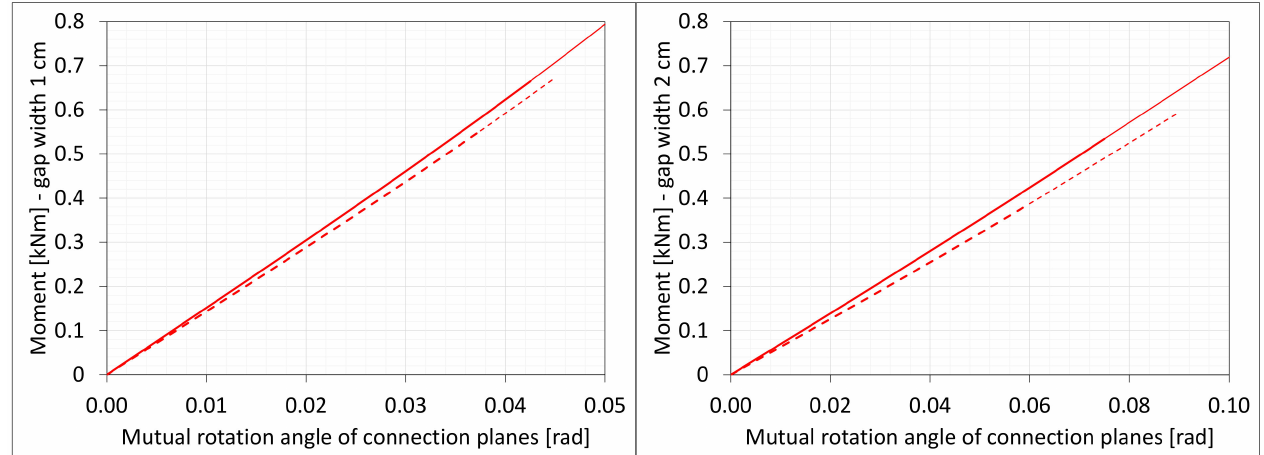
Figure 25. Equilibrium paths for excitation moment M z . The width of the gap is equal to 1.0 cm, left graphic, and 2.0 cm, right graphic. Plane strain models, solid lines; and 3D models, dashed lines (curves from Figure 10). Parts of charts with non-physical deformations are displayed with thin lines.